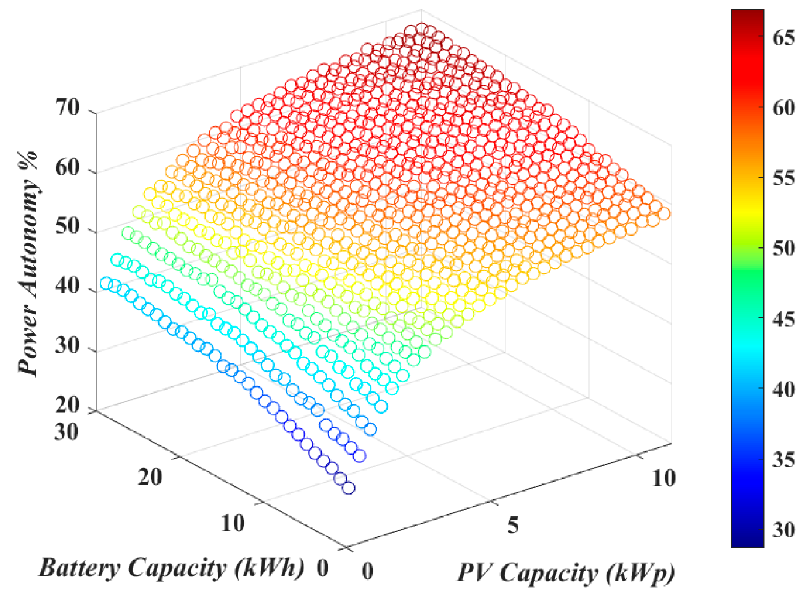
Figure 14. Power autonomy factor performance for different PV-battery system combinations to supply a commercial base station in Aalborg.